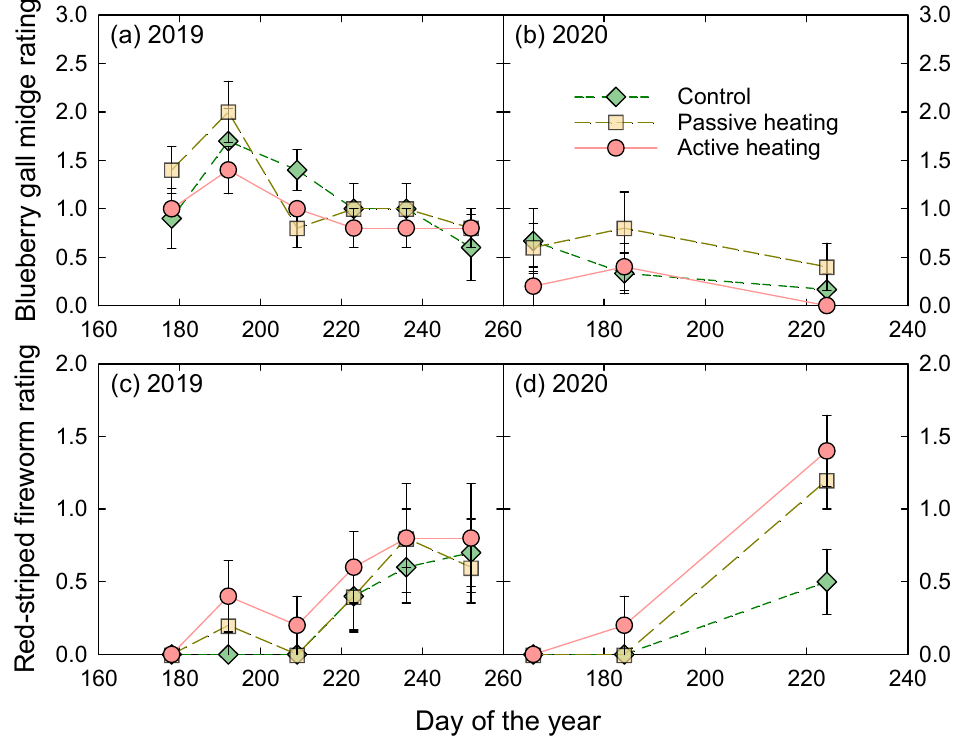
Figure 6. Warming effects on insect pests. The ratings of blueberry gall midge ( a , b ) and red-striped fireworm ( c , d ) of wild blueberries under different treatments in 2019 (prune year; a , c ) and 2020 (crop year; b , d ). The rating ranked from 0–5 (0 = not present, 1 = ≤20%, 2 = 20–40%, 3 = 40–60%, 4 = 60–80%, 5 = 80–100%) of the control plots (CON), passive-heating OTCs (PH) and active-heating OTCs (AH). Data are means ± SEs. Green diamonds with short dashed lines denote the ambient control plots (CON), yellow squares with long dashed lines are PH OTCs, while red circulars with solid lines indicate the AH OTCs. The absence of letters indicates treatments that do not differ significantly ( p > 0.05).